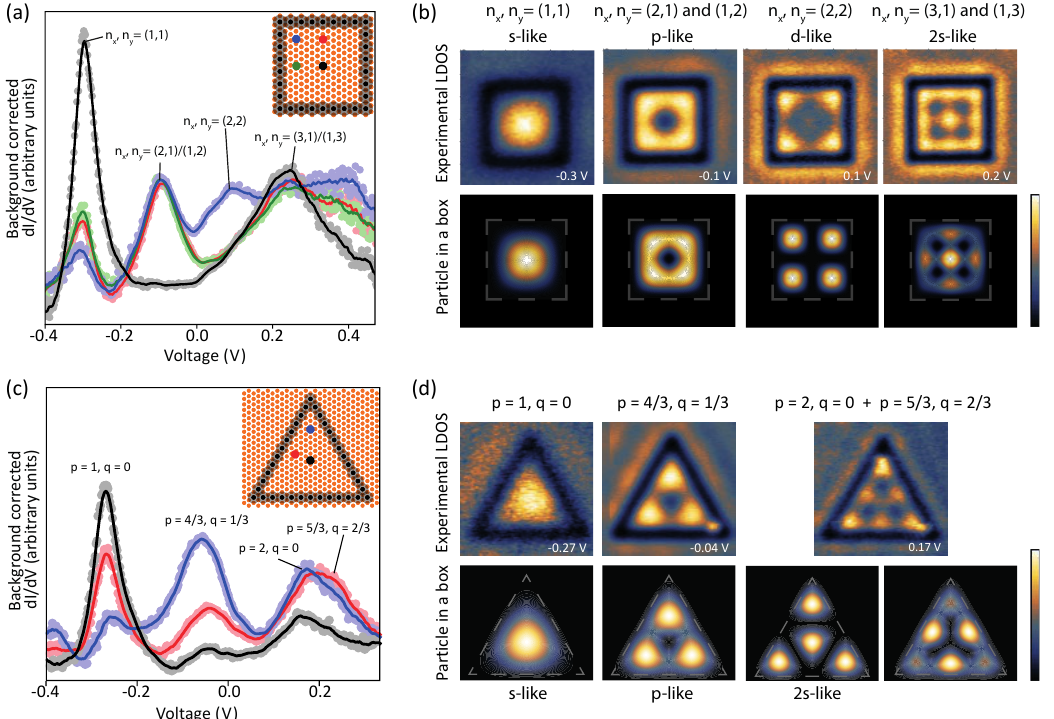
Figure 3: Differential conductance measurements on rectangular and triangular quantum corrals. (a) dI / dV spectroscopy acquired at the positions marked in the inset figure. (b) Top: experimental differential conductance maps (of size 6 nm × 6 nm) acquired at the energies stated; bottom: | Ψ | 2 calculated according to the parti- cle in a box model. The quantum numbers are labeled above each peak in the dI / dV and above each LDOS map. (c), (d) same as (a) and (b) but for triangular quantum corral. The images depict an area of 6.25 nm × 6.25